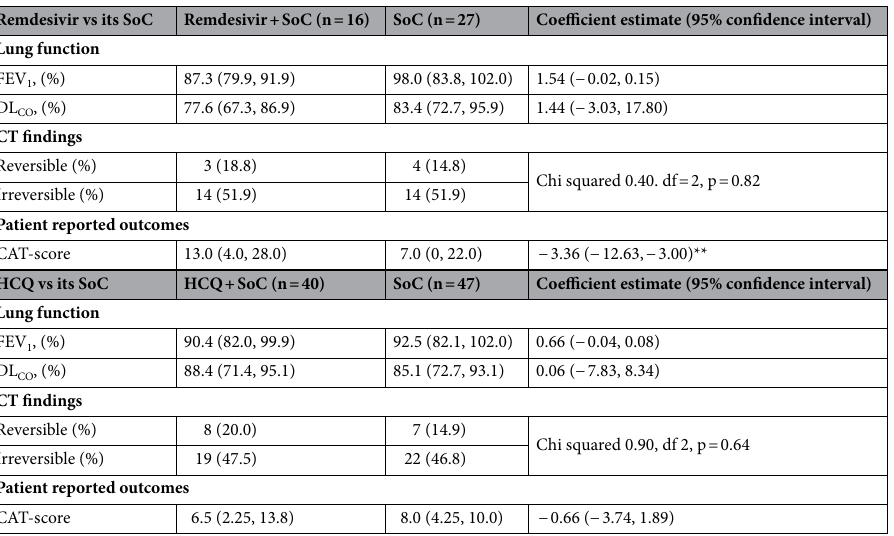
Table 3. Effect of medication on patient reported outcomes, lung function and CT-findings 3 months after intervention. Median values (25th, 75th percentile) unless otherwise specified. Comparison done by Welch t-test for continuous variables and Pearson’s Chi squared test for categorical variables. Reversible CT findings defined as presence of any ground glass opacities and any mosaic pattern. Irreversible CT findings defined as presence of any parenchymal bands, consolidations, reticular pattern, interlobular septal thickening, or bronchiectasis. SoC standard of care, FEV 1 forced expiratory volume in 1 s, in percent of predicted, DL CO diffusion capacity of the lungs for carbon monoxide, in percent of predicted, CT computed tomography, CAT the COPD assessment test, HCQ hydroxychloroquine, df degrees of freedom. **p < 0.01.